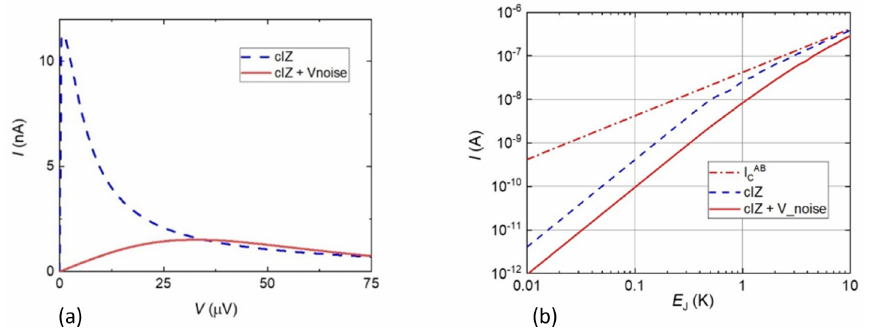
Figure A4. ( a ) The supercurrent branch of the IVC of a JJ with E J = 1 K at T = 50 mK, predicted by the classical IZ theory (dashed line) and its modification in presence of gaussian noise with amplitude 24 µ V (solid line). ( b ) Nominal critical current (dot-dashed line), switching current according to the IZ theory without (dashed line) and with (solid line) extra voltage noise of the same